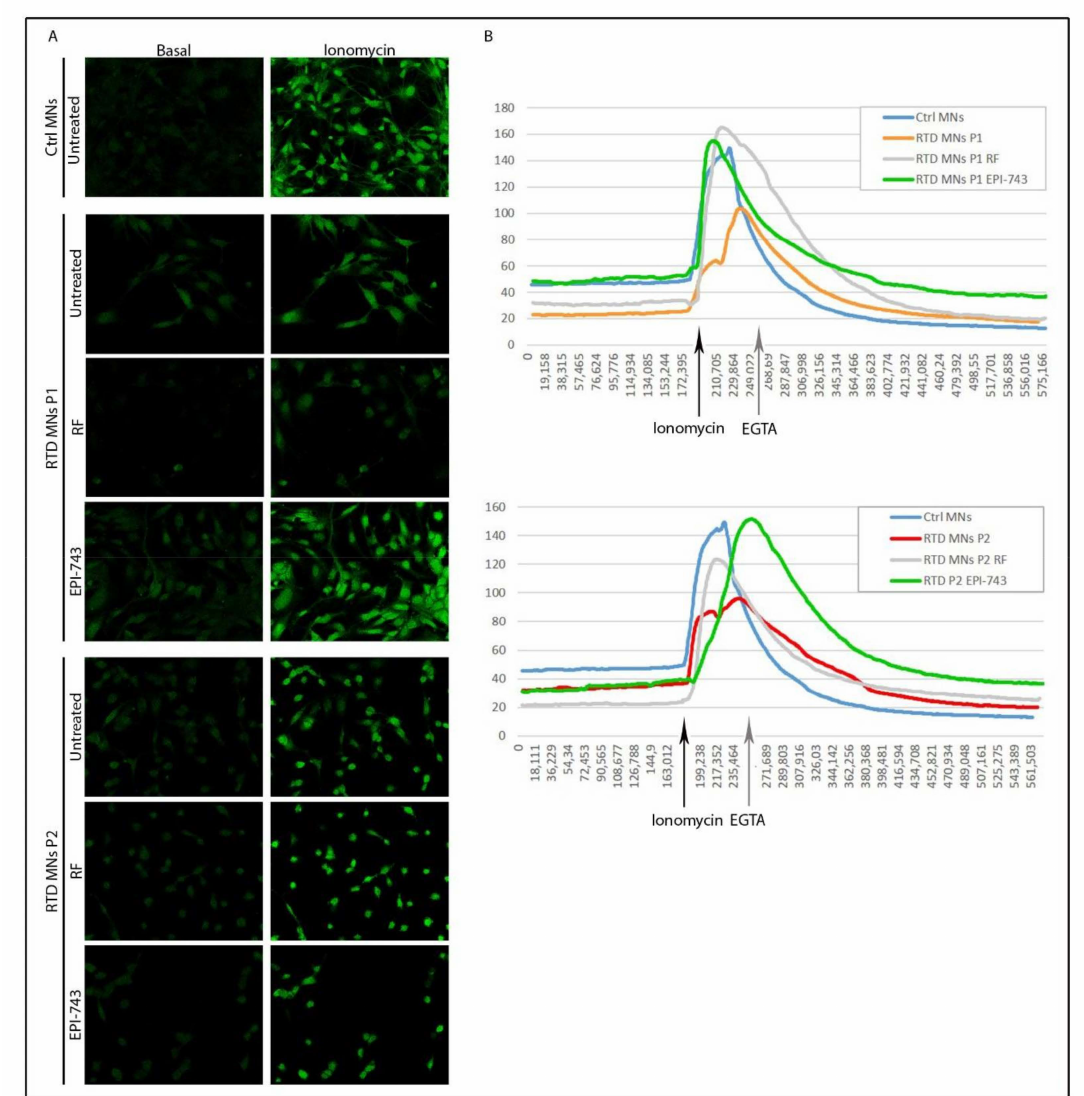
2.4. EPI-743 Has a Beneficial E ff ect on the Intracellular Calcium Levels in RTD MNs Intracellular calcium levels play a fundamental role in synaptic activity and in many other biological functions. Consequently, calcium imaging is used to quantify neuronal activity. It is known that control MNs functionally responded to calcium mobilization following ionomycin stimulation, and patient-derived MNs presented altered calcium homeostasis [49]. We confirmed that before ionomycin stimulation (basal conditions), the intracellular calcium levels were lower in both RTD MNs, and that even following ionomycin the maximal peak of intracellular calcium in RTD MNs was decreased compared to Ctrl MNs (Figure 4). Importantly, treatment with RF or EPI-743 considerably, increased intracellular calcium levels. However, despite RFs increasing the maximal intensity of RTD MNs to levels comparable to Ctrl MNs, the basal levels of calcium did not change following RF supplementation. The basal calcium levels of P1 RTD MNs, however, were restored to Ctrl levels following EPI-743 treatment without RF. These results support the notion that EPI-743 improves the intracellular calcium flow in RTD MNs compared to untreated MNs, and that this e ff ect is stronger compared to that observed with RF